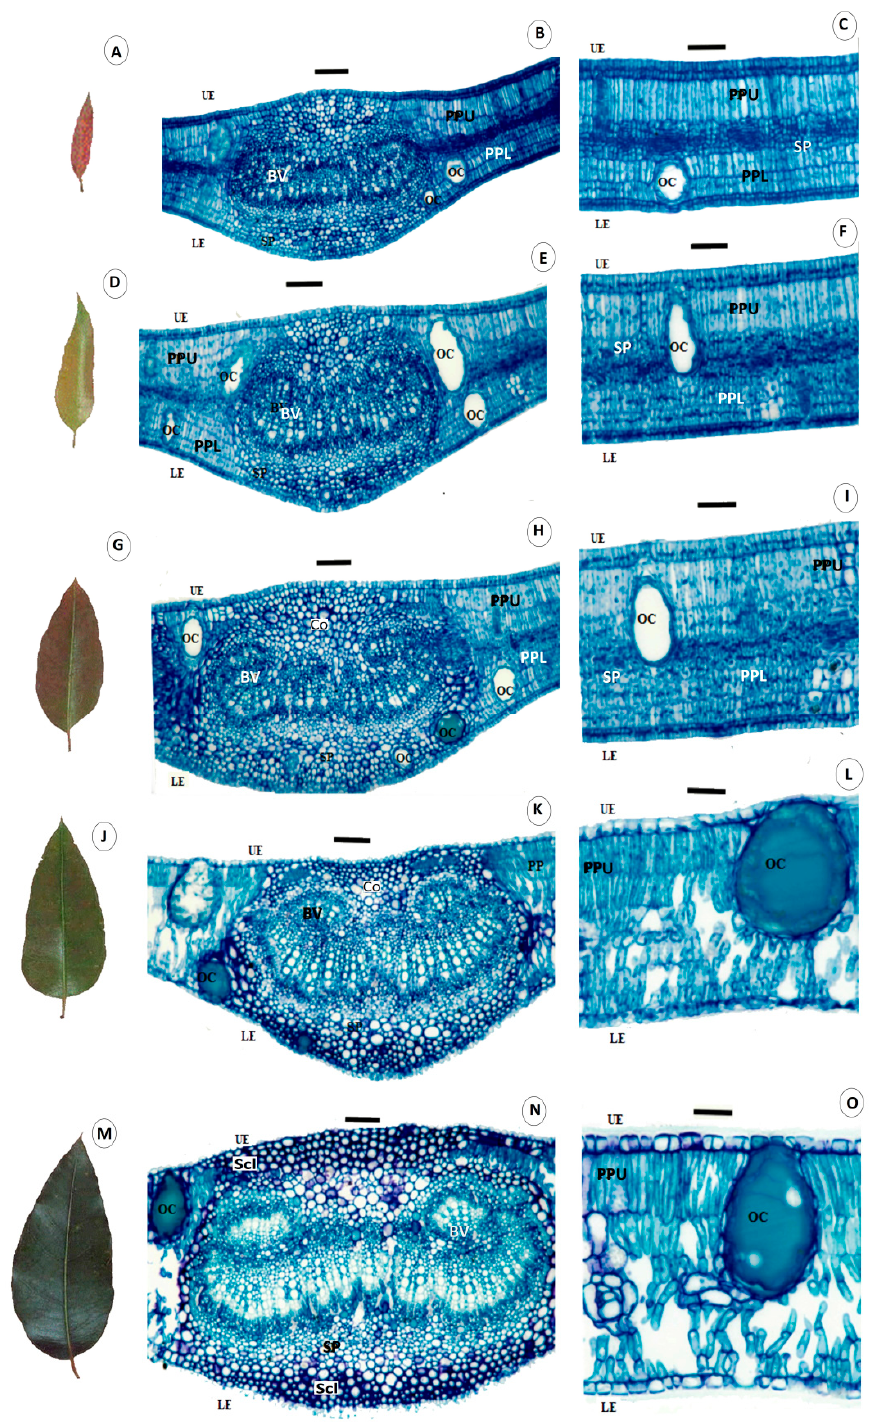
Figure 2. Light micrographs of the first ( A – C ), second ( D – F ), third ( G – I ), fourth ( J – L ) and fifth ( M – O ) leaf-growth stages of Eucalyptus grandis . Transverse sections of the midrib ( B , E , H , K , N ) and the internervural region ( C , F , I , L , O ). UE = upper epidermis tissue, LE = lower epidermis, PPU = palisade parenchyma upper, PPL = palisade parenchyma lower, SP = spongy parenchyma, Co = collenchyma, Scl = sclerenchyma-like tissue, OC = area of oil cavities, and BV = vascular bundles. Scale bars: 92 ( B , E , H , K , N ) and 46 µm ( C , F , I , L , O ). The five leaf development stages of young and adult E. grandis plants differed, based on the dendrogram (Figure 3) and graphic dispersion (Figure 4), resulting from 13